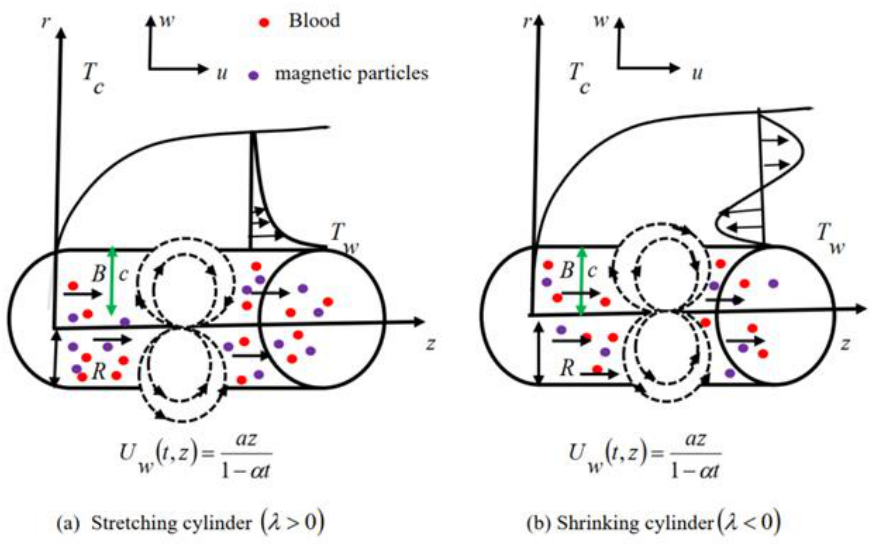
Figure 1. Graphical representation and coordinate system of given flow problem ( a ) for stretching cylinder and ( b ) for shrinking cylinder. Under the above assumptions the idea of [34] is explored and the continuity, momen- tum and energy equations in cylindrical coordinates take the following form: